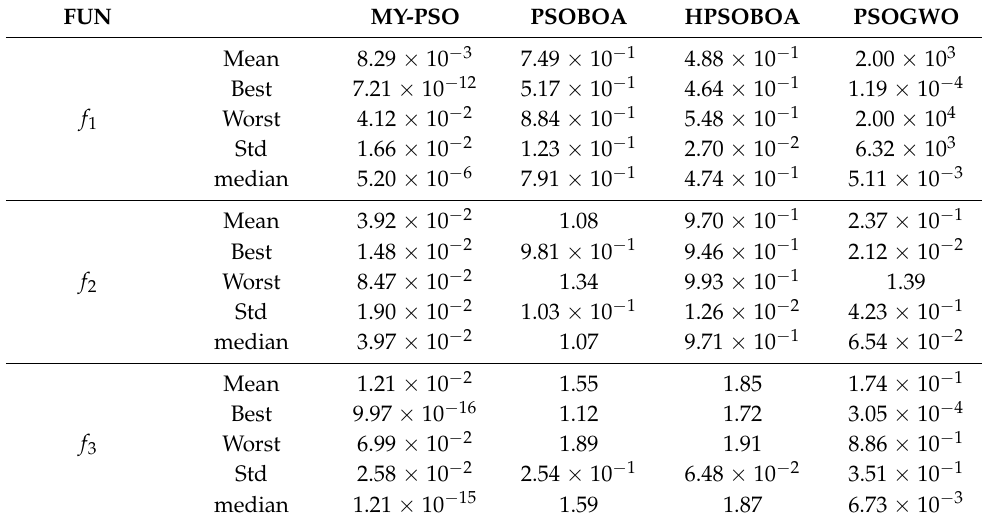
Table 5. Comparisons of experimental results between SHPC and hybrid